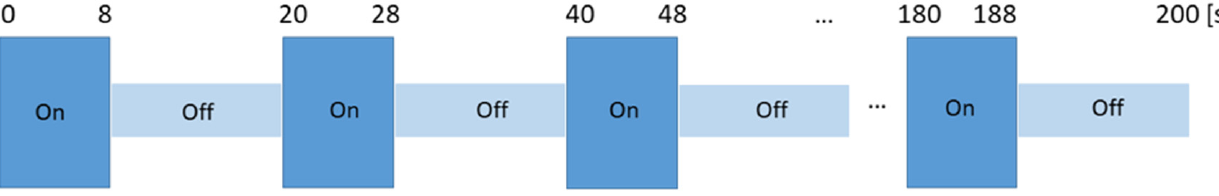
Figure 1. Experimental design for odor presentation. ON session corresponds to the “odor session” where an odor was released for 8 s and OFF session corresponds to the “unscented air session” lasting 12 s. ON-OFF sessions were repeated 10 times. Four sessions were conducted per subject, each lasting 200 s (s).